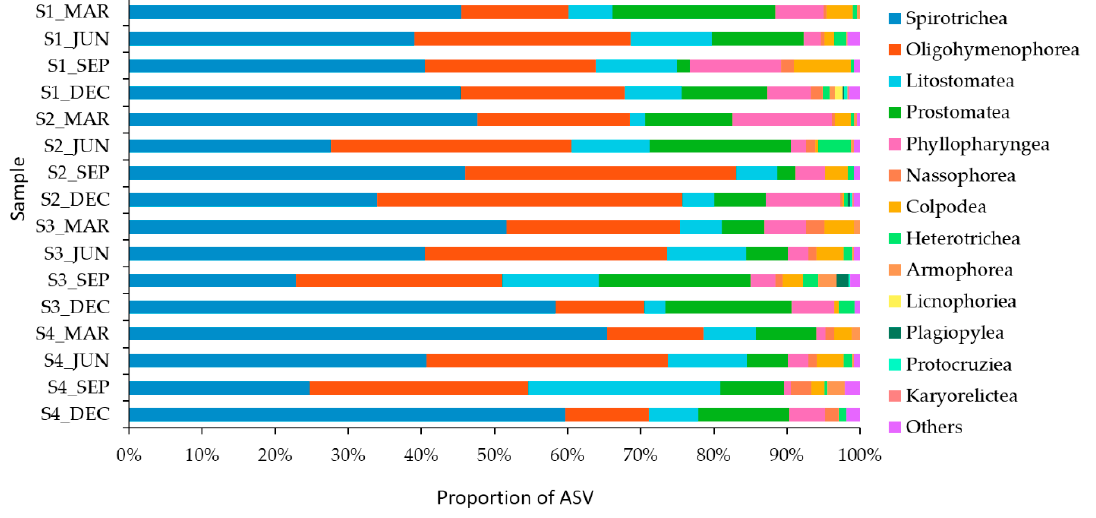
Figure 6. Proportion of ASVs assigned to major classes of ciliates across seasonal samples from four estuarine stations (S1–